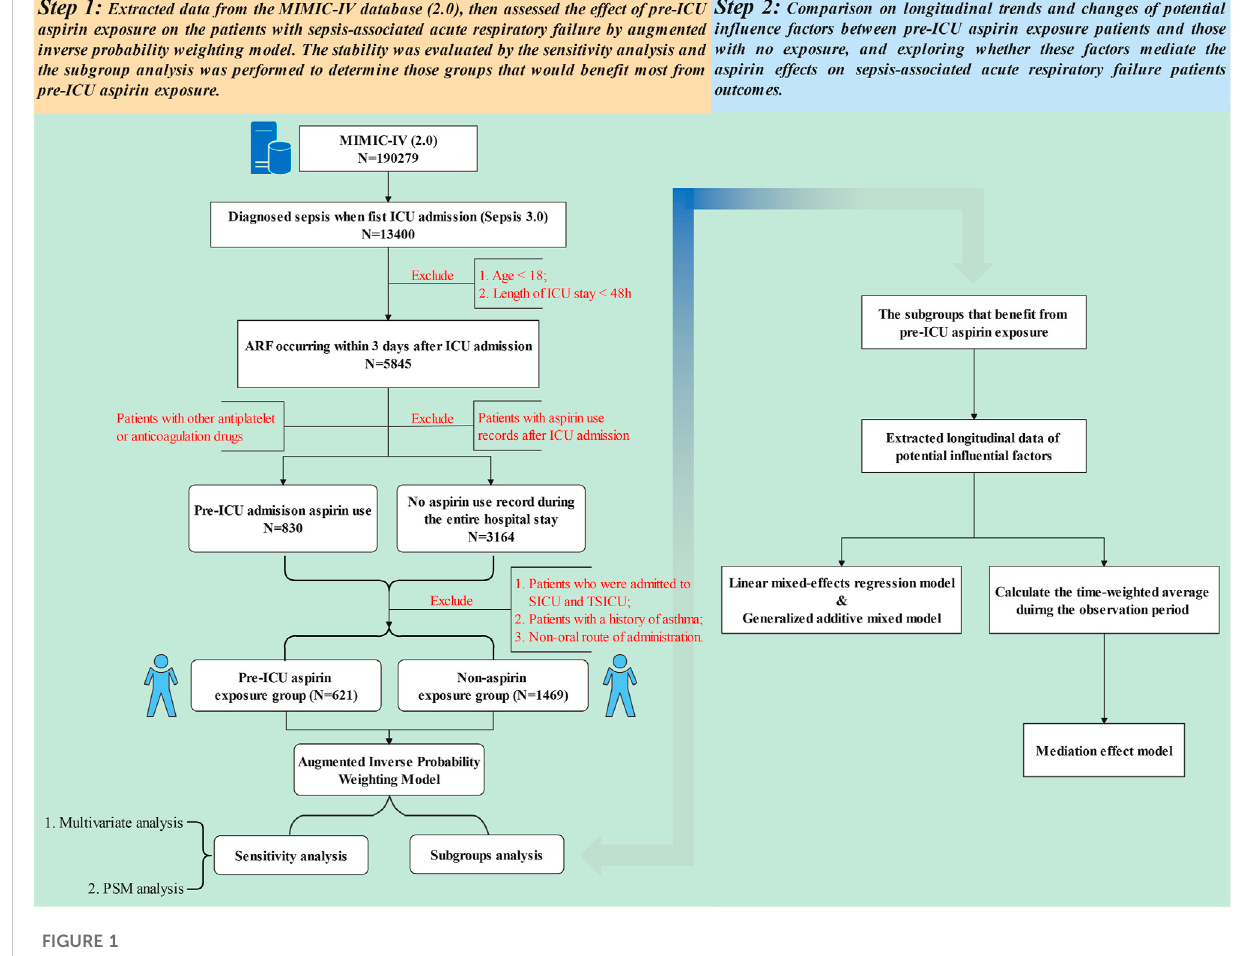
FIGURE 1 Flowchart of this present